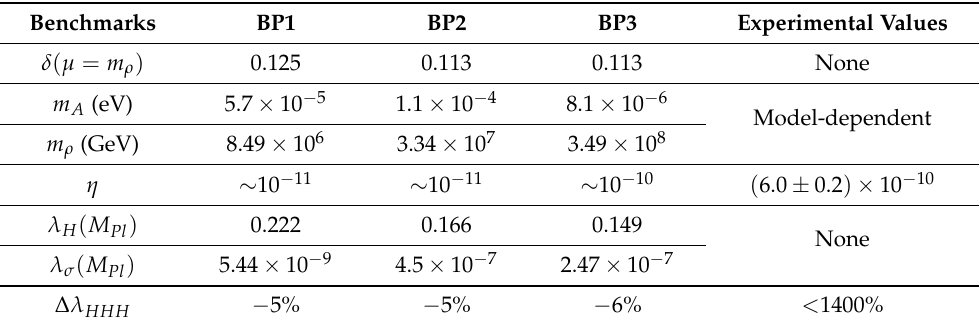
Table 4. The computed values of threshold correction δ , BSM scalar masses m A and m ρ , baryon- to-photon ratio η , quartic self-couplings at M Pl , correction to the triple Higgs coupling ∆ λ HHH compared to the SM